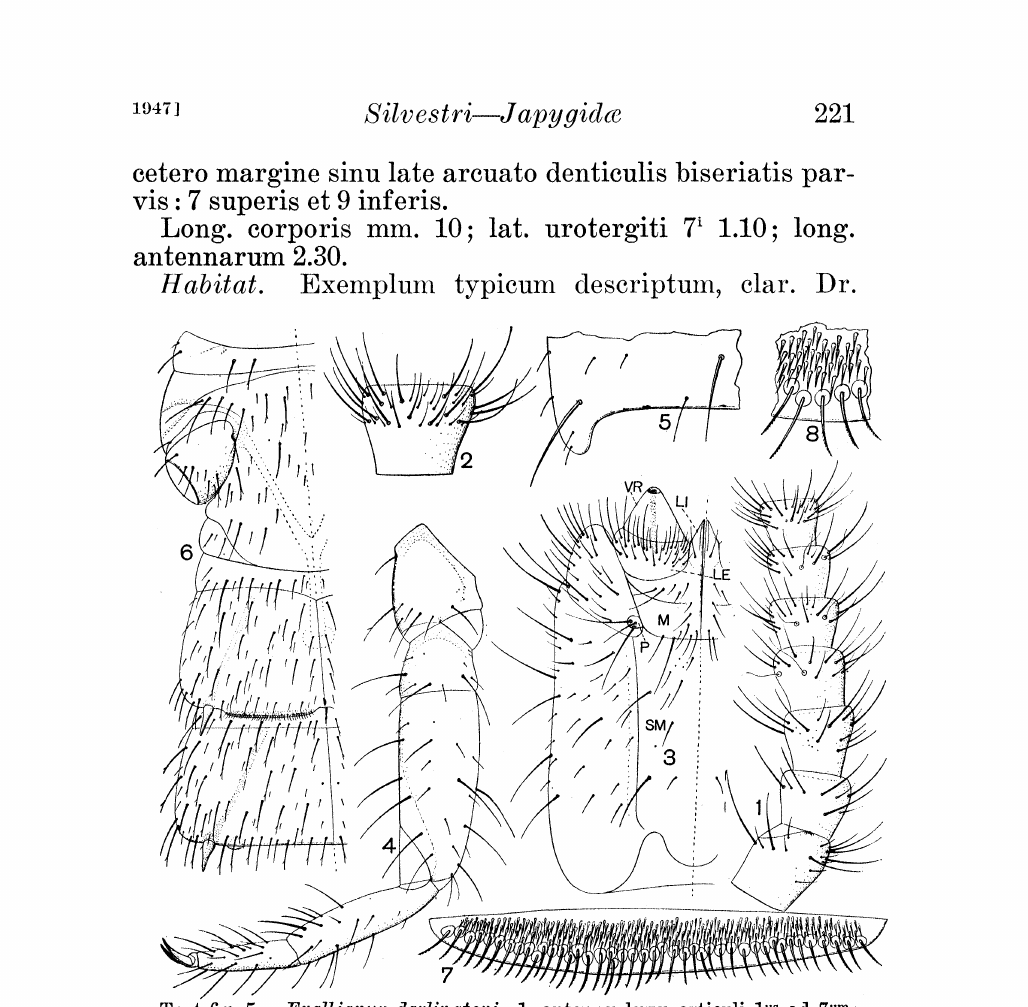
-. Text-fig. 5. Evalljapyx darlingtoni: 1. antenn lmvm articuli lus ad 7urn; 2. eiusdem antennm articulus 10us magis ampliatus; 3. caput subtus inspectum T infundibulum subanticum, LE labii lobus externus, LO eiusdem lobus inter- nus, M mentum, P. palpus labialis, SM submentum, VR vesicula retractilis; 4. pes pris 31; 5. urotergiti 7 angulus posticus; 6. metasternum cum uro- sternis lo et 20; urosterni li organus subcoxalis; 8. eiusdem particula magis ampliata (figg. varie